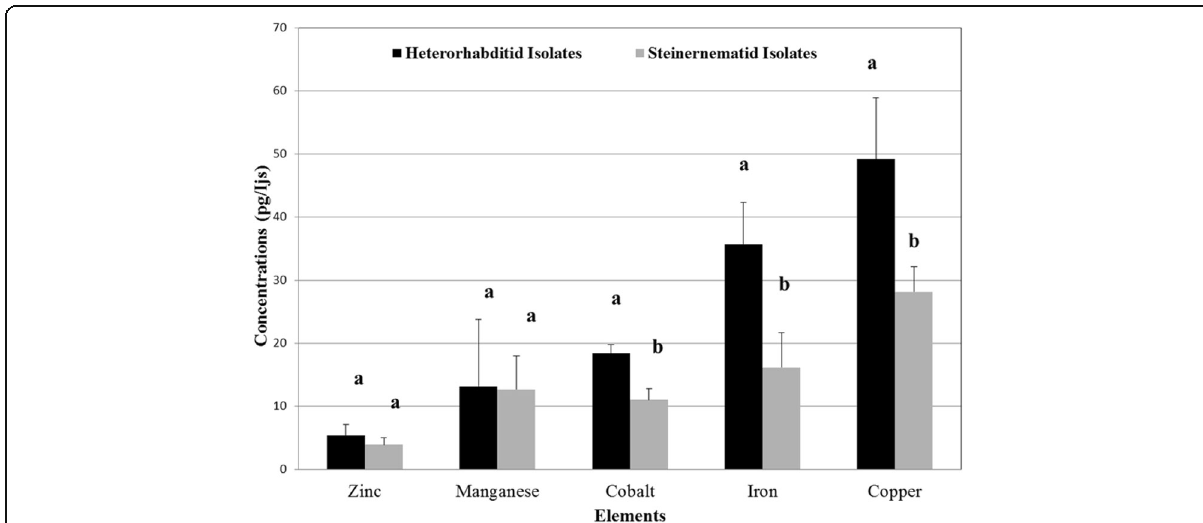
Fig. 1 Variations of cobalt, manganese, zinc, iron, and copper contents (mean ± SD) between the infective juveniles of heterorhabditid and steinernematid isolates (adjacent bars with different letters are significantly different, P <